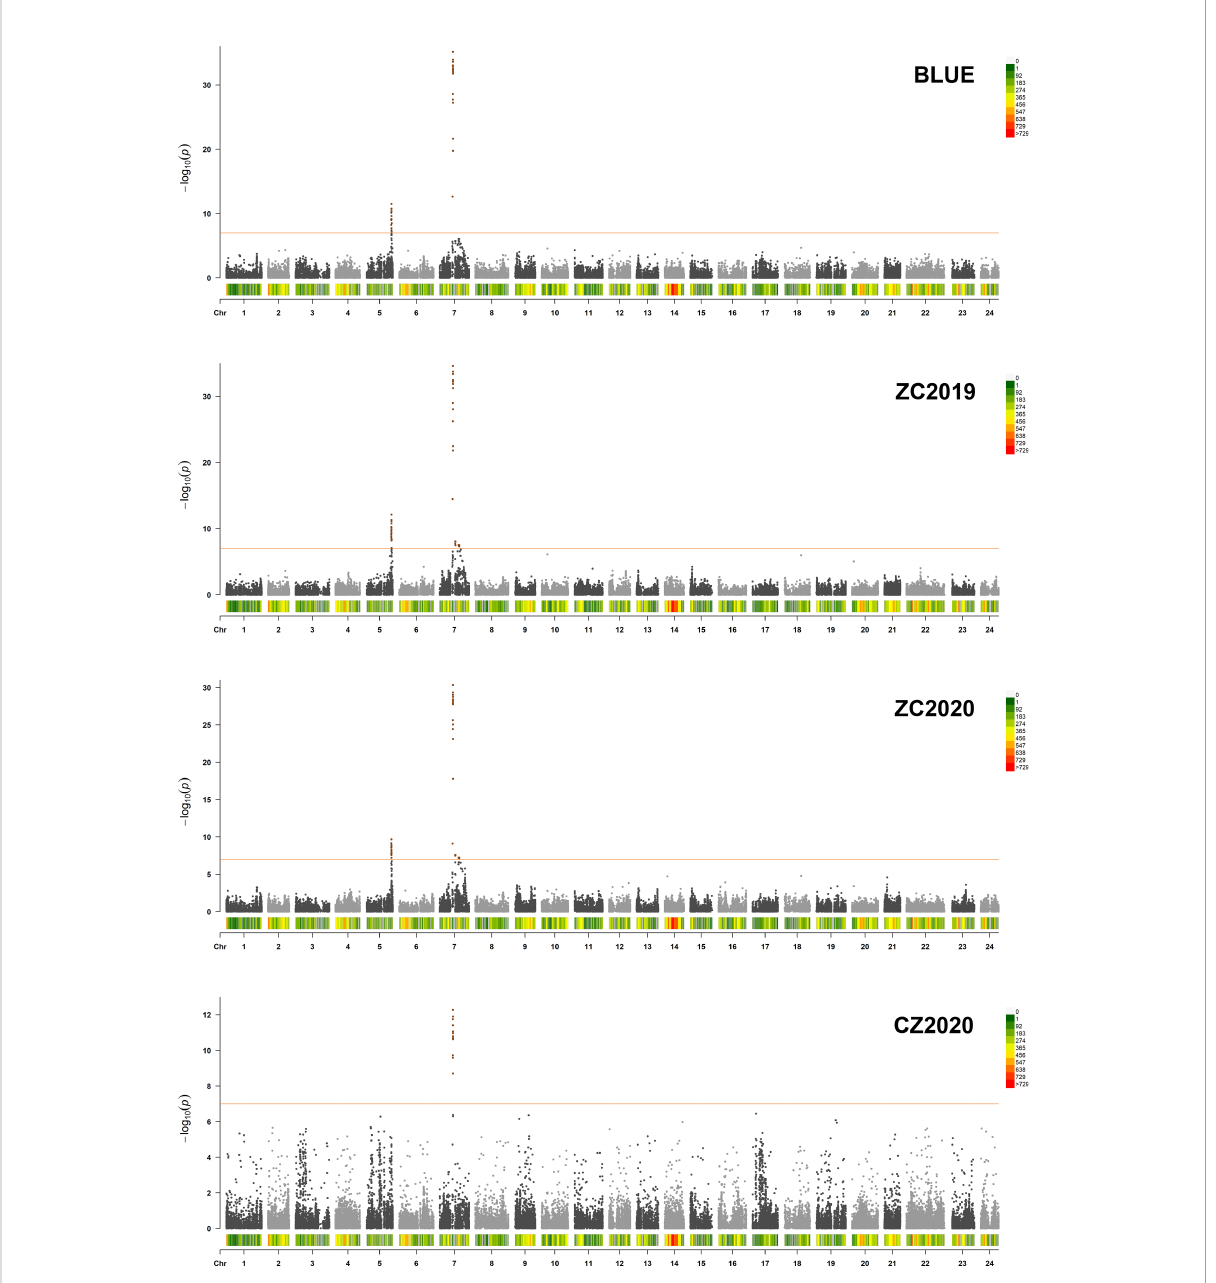
FIGURE 3 Manhattan Plot for nicotine content generated from GWAS analysis following mixed linear model (MLM). X-axis and Y-axis represent physical position of 24 chromosomes and negative log 10 ( p -value), respectively. Different colors at the top right corner and bottom of manhattan plot represent different densities of SNP markers. Horizontal solid line represents the signi fi cant threshold ( p =1.0E-07). SNP markers with p < 1.0E-07 were colored in dark